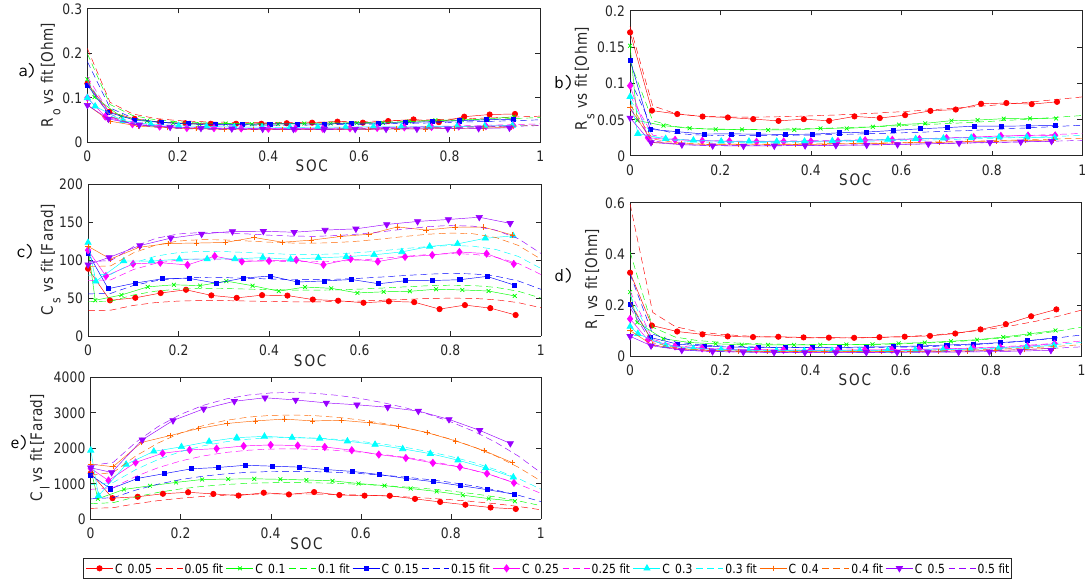
Figure 9. The values of RC elements and their fitted results: VRLA batteries during